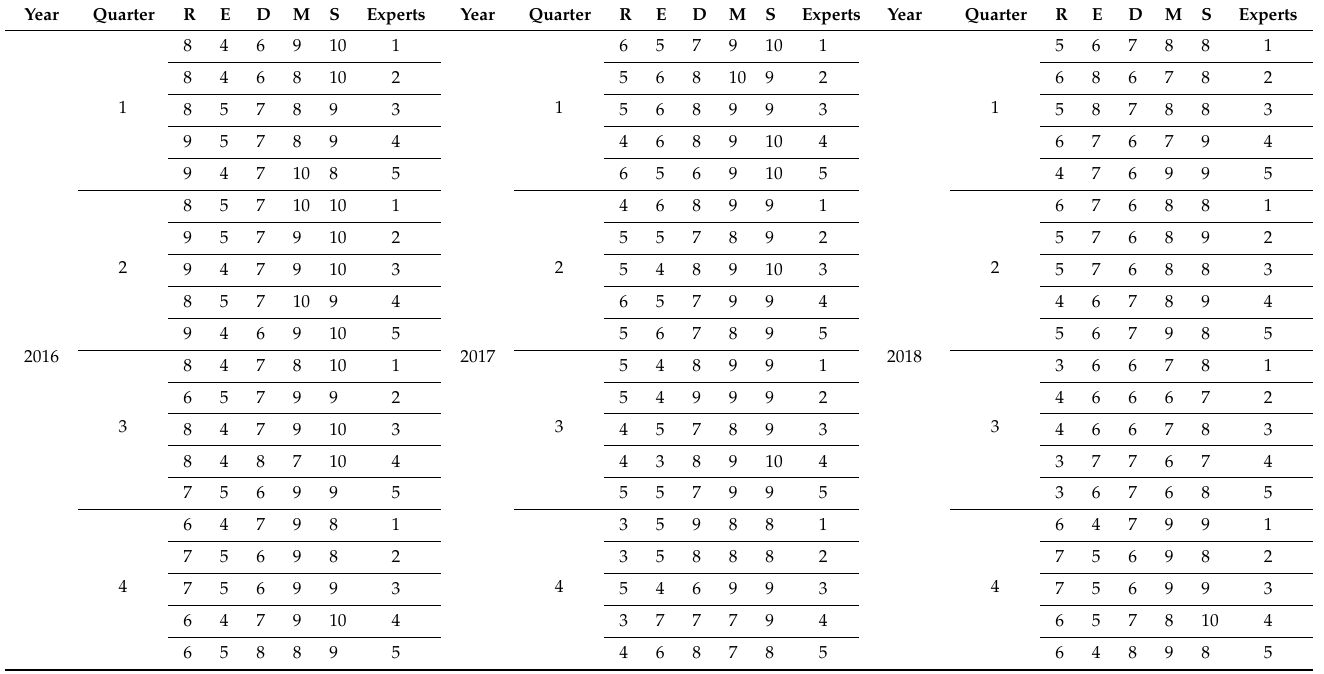
Table 1. Expert evaluations for partial indicators of system availability in the period from 2016–2018.